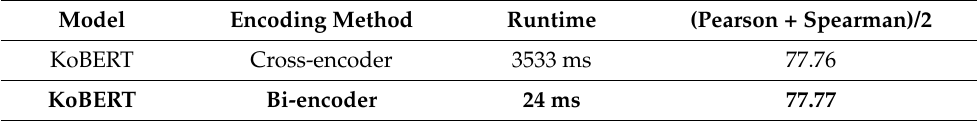
Table 3. Experimental results of dense embedding retrievers on the KorSTS test dataset. Model